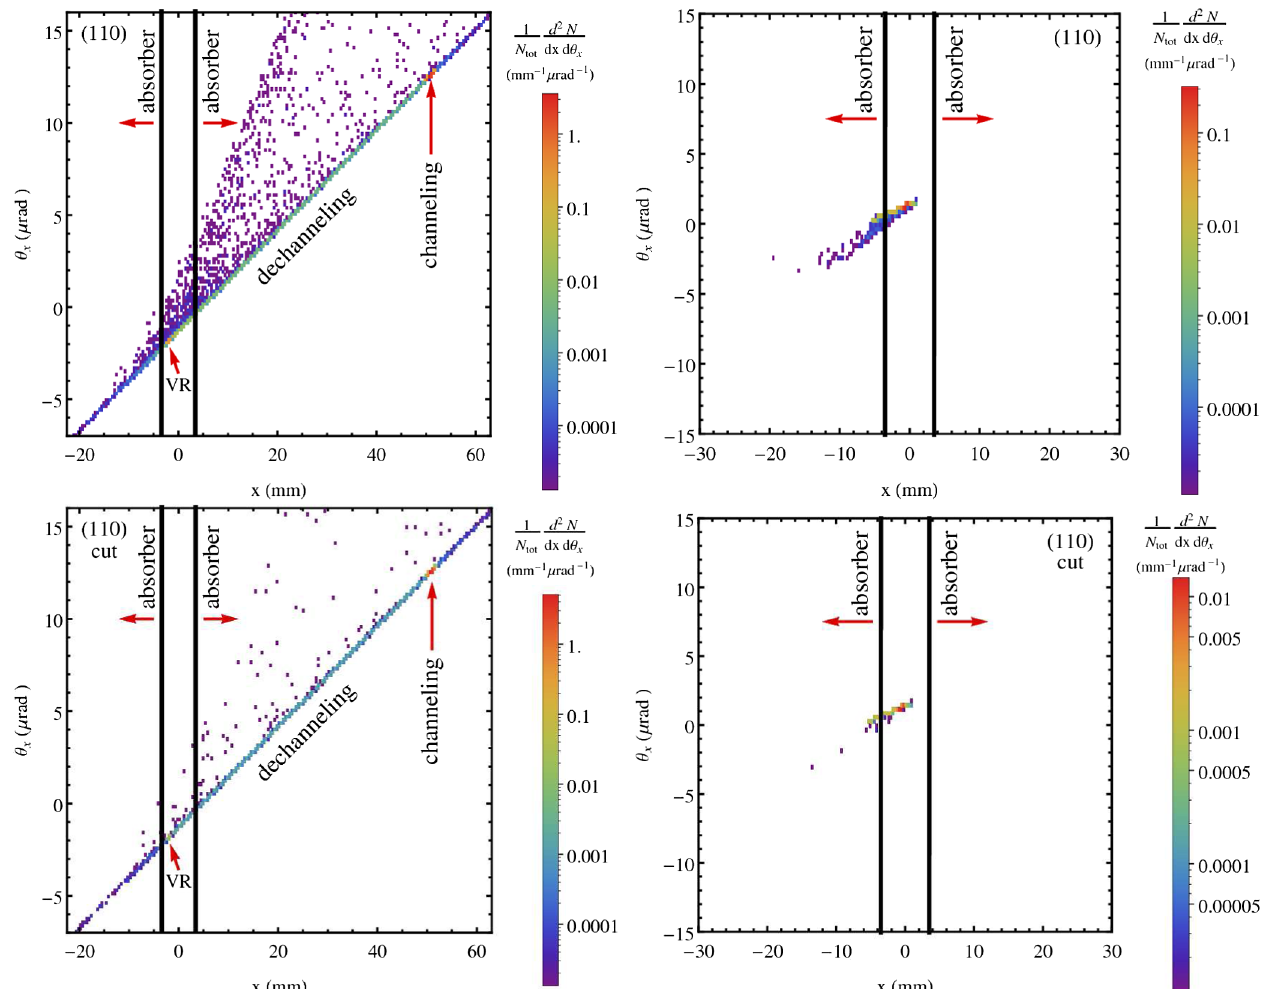
FIG. 13. Beam phase space, normalized to the total number of particles, passed through the cleaning insertion, at the position of the first (left) and the second (right) absorber for single crystal-based collimation system. The Si crystal the same as in Fig. 10, aligned for planar channeling in (110) vertical crystal planes without cut (top) and with cut (bottom). The crystal and the absorbers are placed at 7.2 and 12 . 6 σ ,